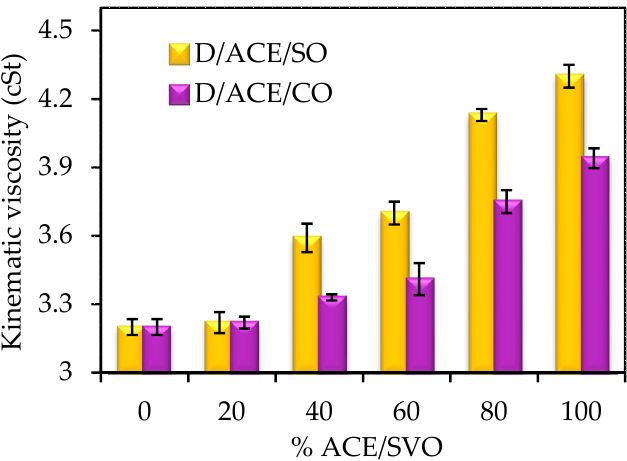
Figure 1. Kinematic viscosity values at 40 °C of diesel/acetone/sunflower oil and diesel/acetone/castor oil triple blends. The measure error is represented as standard deviation, using error bars. Table 2. Cloud point, pour point and calorific value of diesel / acetone / sunflower oil blends, obtained by adding di ff erent amounts of fossil diesel to acetone / sunflower oil double mixture, containing 40% acetone. Errors are always calculated from the average of three